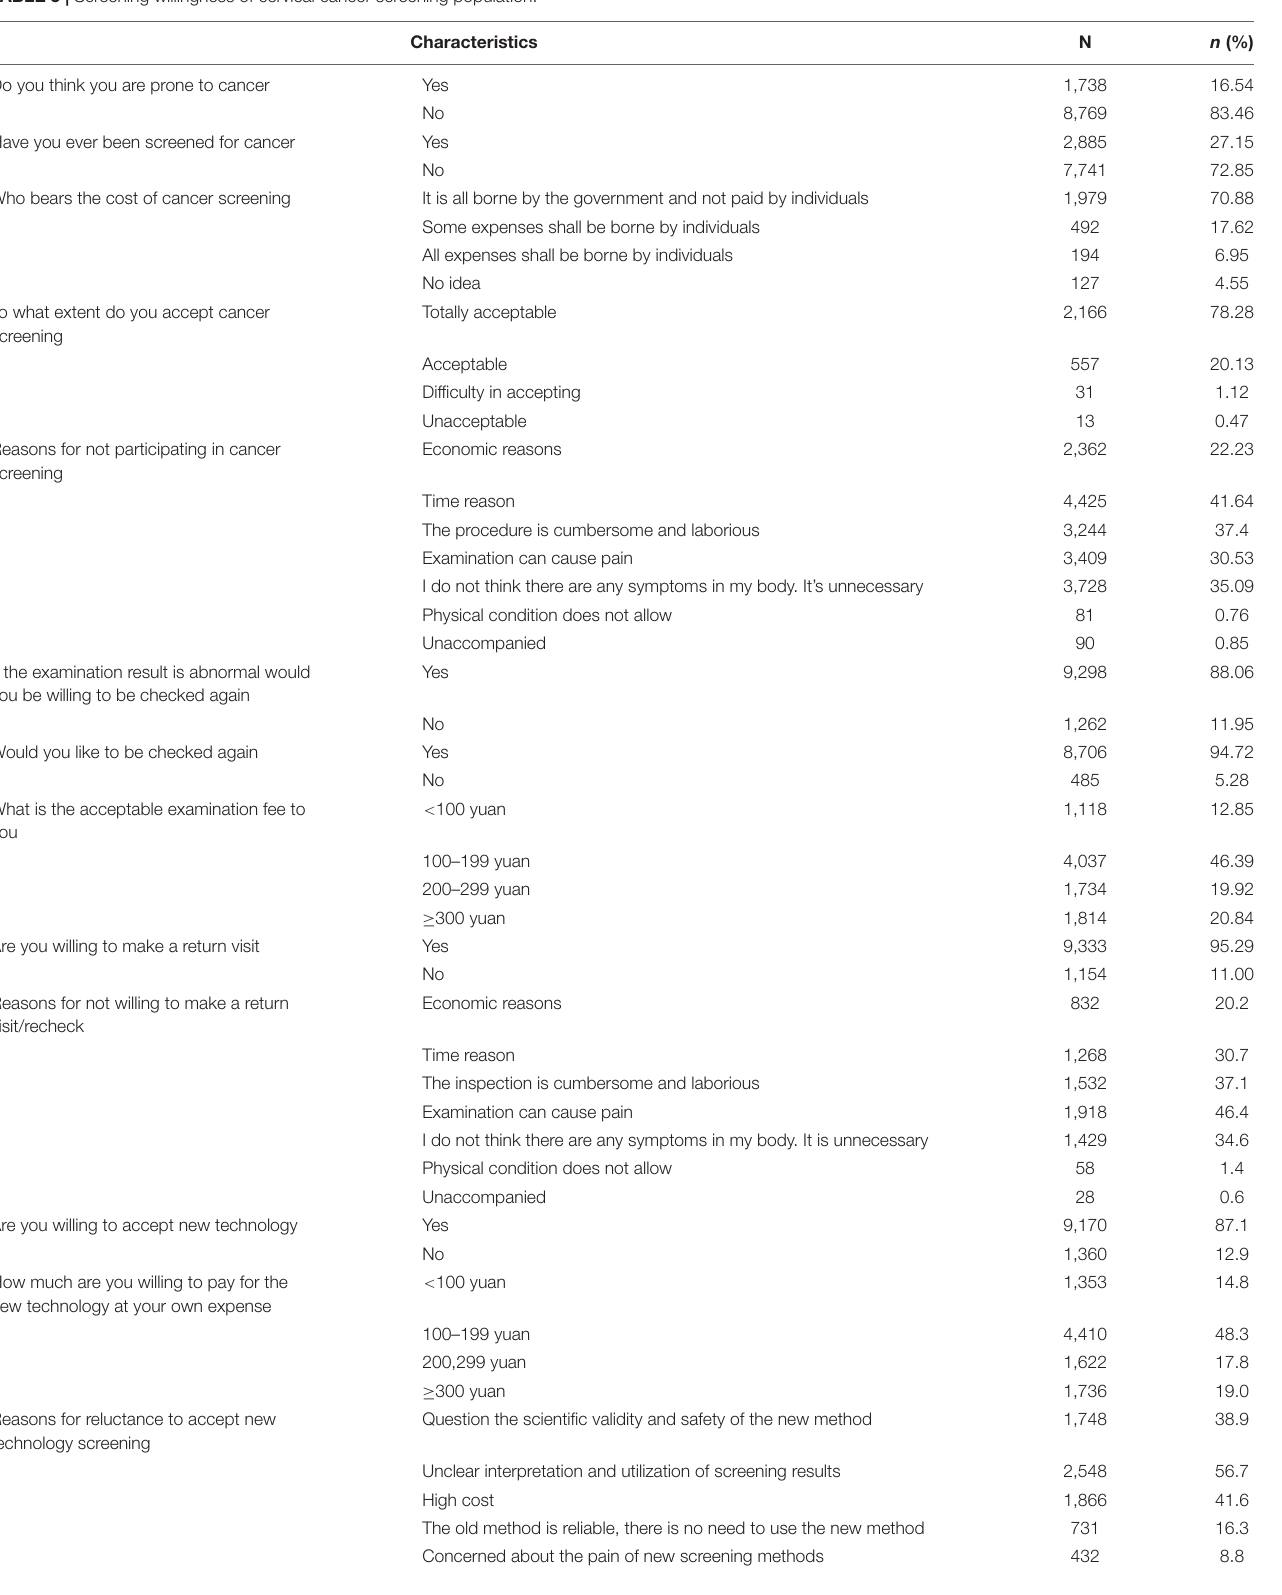
TABLE 5 | Screening willingness of cervical cancer screening population.